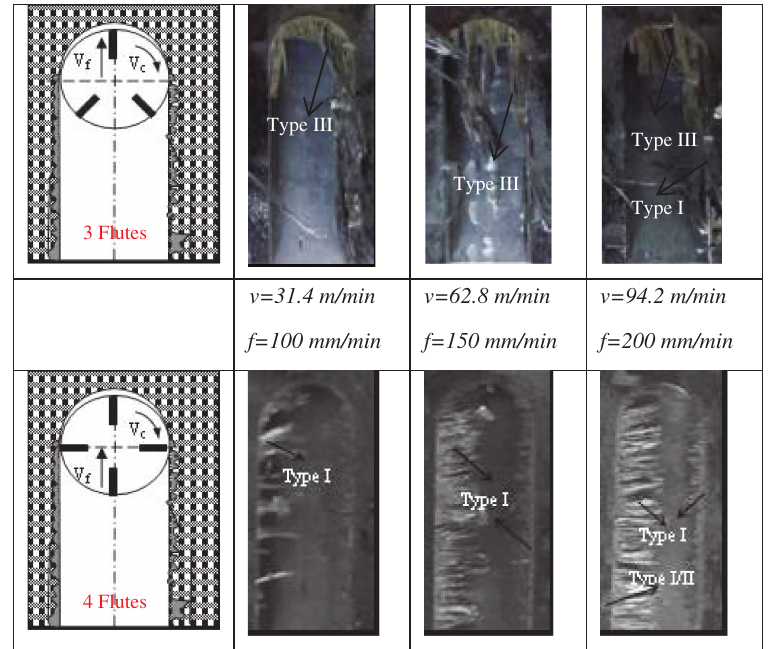
Figure 5 Different types of deformation in milled